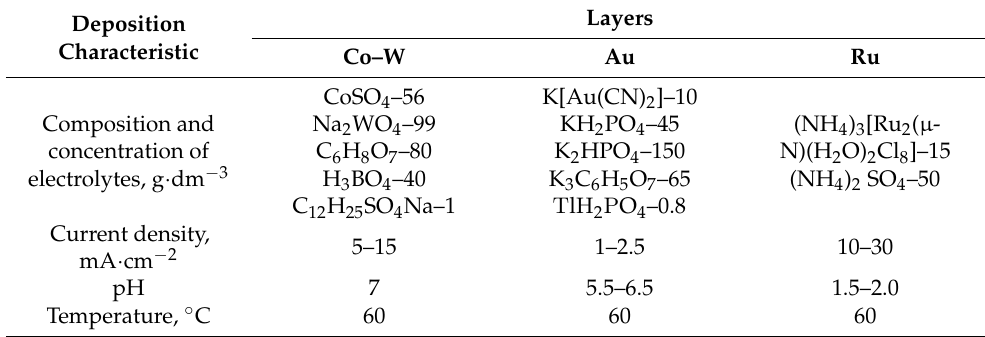
Table 1. The electrolytes ’ composition and characteristics of deposition modes.